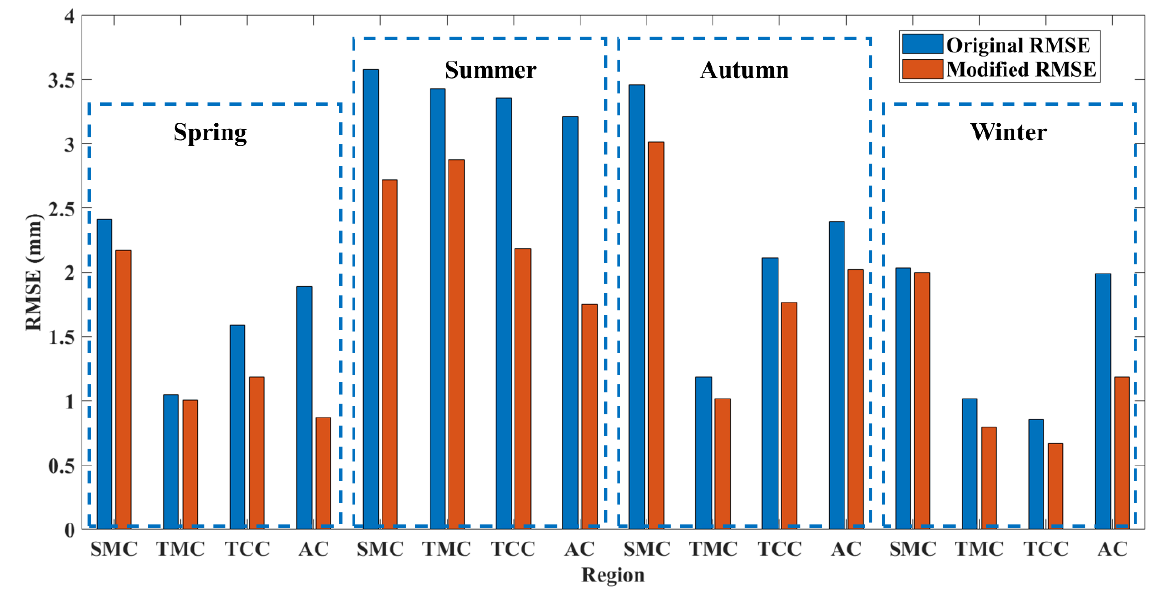
Figure 14. Comparison of RMSE between ERA5 PWV and GNSS PWV before and after calibration.